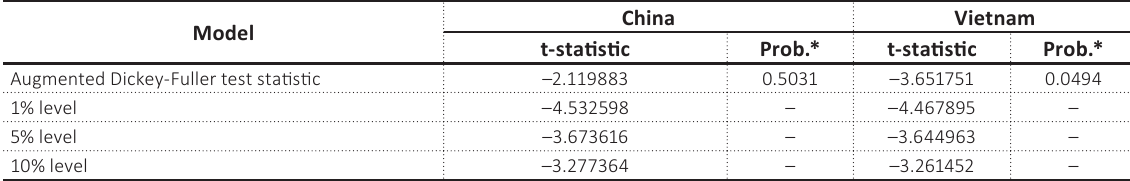
Table 2. Inflation: 0-degree difference test – I(0)